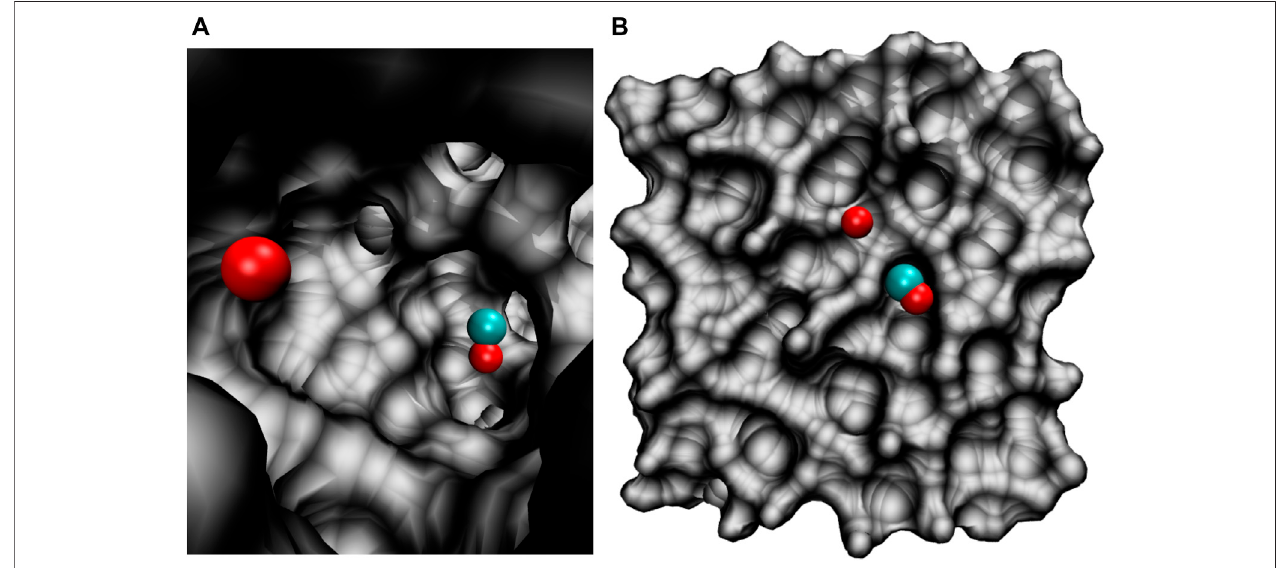
FIGURE1| The simulation systemfor studying theO( 1 D)+CO( 1 Σ + ) → CO 2 ( 1 Σ + g ) recombination reaction. (A) : COand Otrapped inside acavityofASW; (B) : CO and O on the top of the ASW surface.